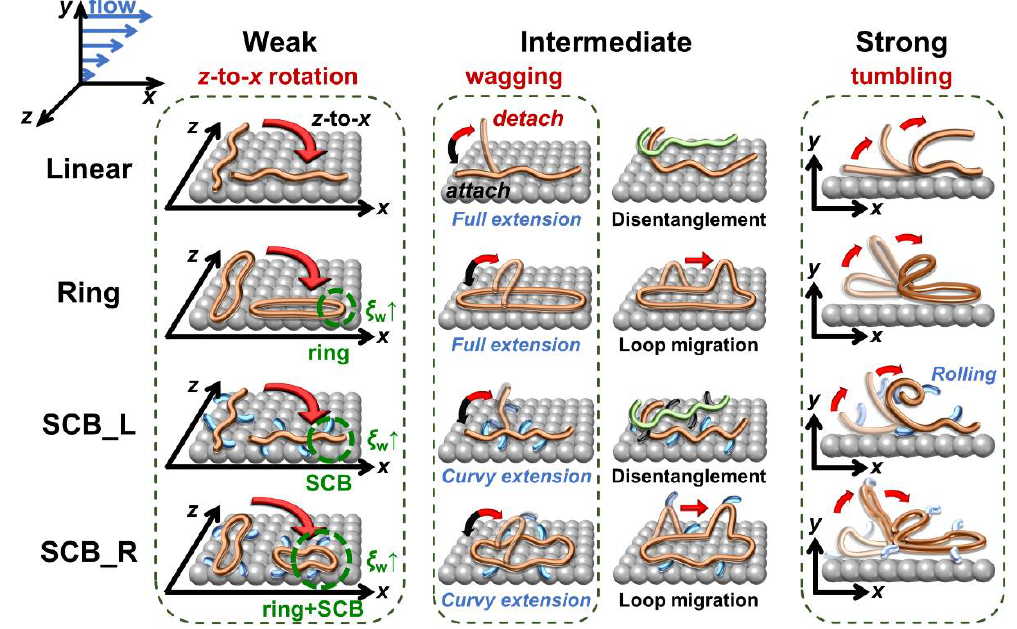
Figure 2. Schematic description of the characteristic molecular mechanisms for the interfacial linear, ring, SCB linear, and SCB ring polymers in the three representative (weak, intermediate, and strong) flow regimes. These mechanisms underlie the general behavior of the interfacial slip ( d s ) for each system. ξ w denotes the polymer-wall friction coefficient.